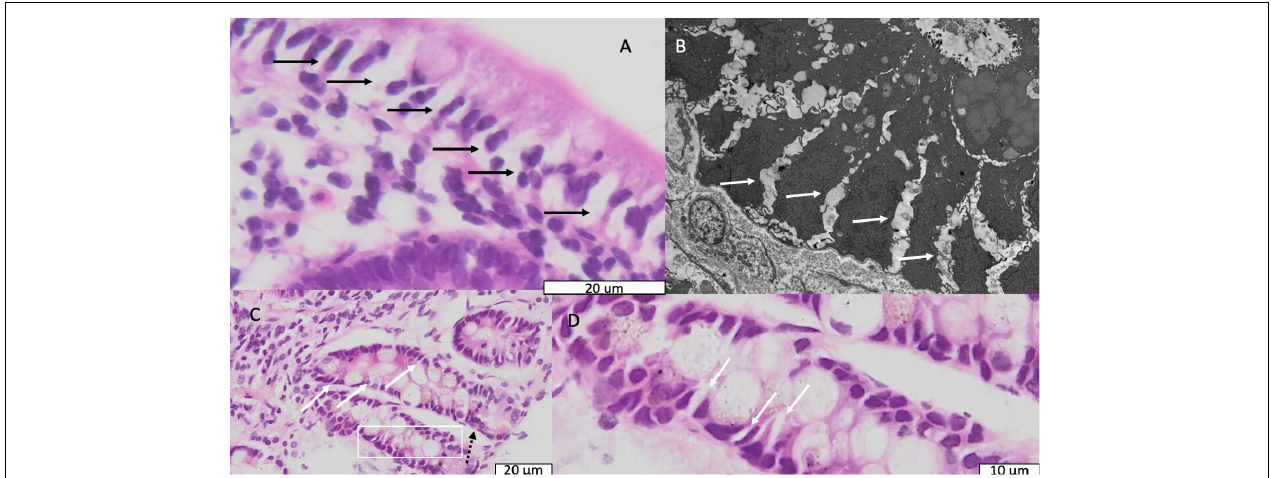
FIGURE 3 | Light and electron micrographs showing dilated intercellular spaces. (A) Light micrograph of epithelium in a biopsy from a child with stunting; black arrows indicate dilated intercellular spaces. (B) Electron micrograph from the same child as panel (B) . Solid white arrows indicate dilated intercellular spaces. (C) Light micrograph of crypts in a biopsy from a different child showing the same dilated intercellular spaces; the dotted black arrow indicates an enteroendocrine cell. (D) Further magnification of the are in panel (C) represented by the white box showing the dilated intercellular spaces more clearly.